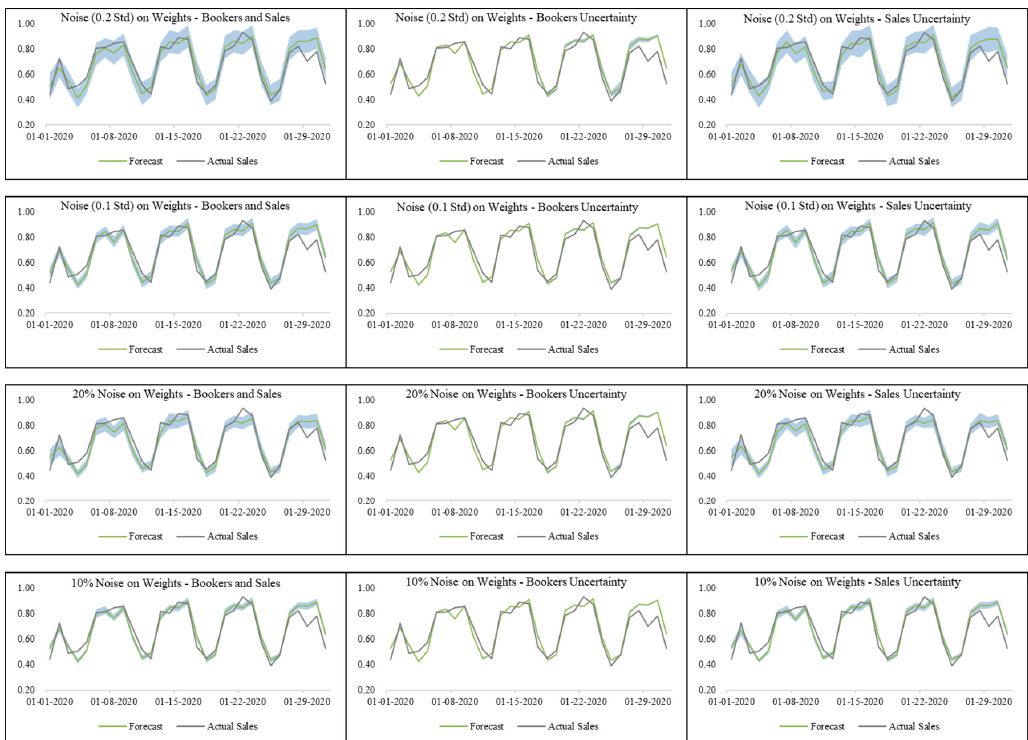
Figure A2. Actual vs. predicted sales forecast of stochastic—noise on weights models. The y -axis represents the normalized sales, whereas the x -axis represents the dates of January 2020. The shaded area represents the range of stochastic variance (uncertainty) in the model predictions.